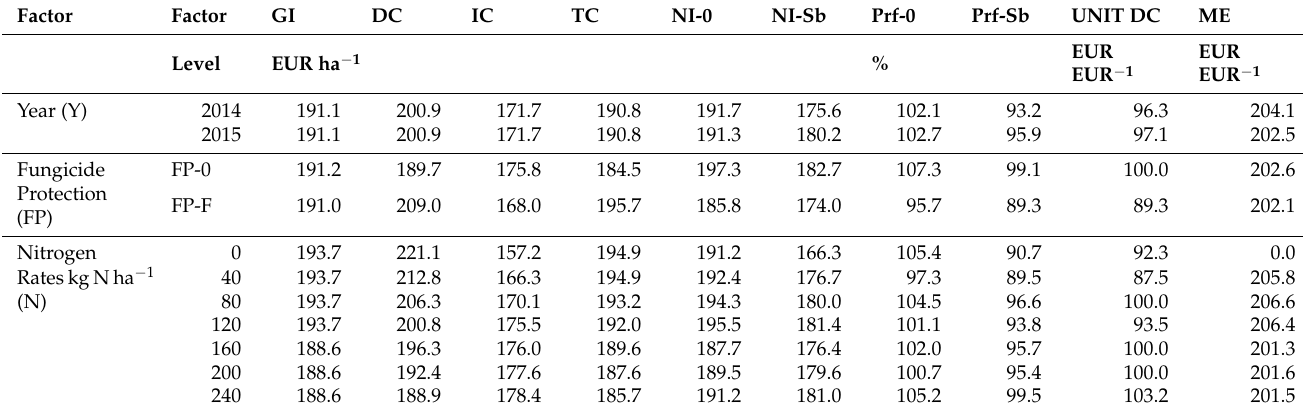
Table A4. Dynamics of economic indicators—for costs 2015 and 2022, where 2015 = 100.